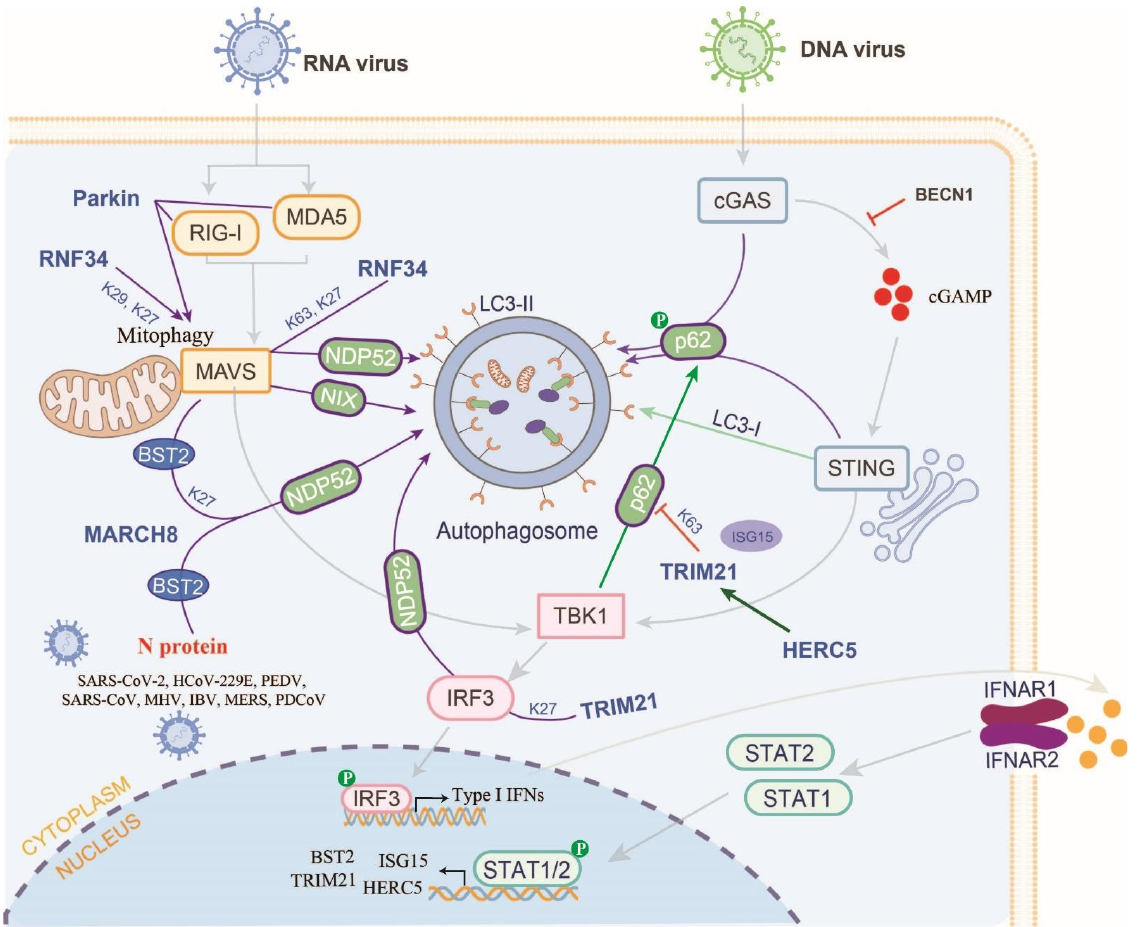
Figure 4. E3s are hijacked to regulate host antiviral responses via selective autophagy. E3s